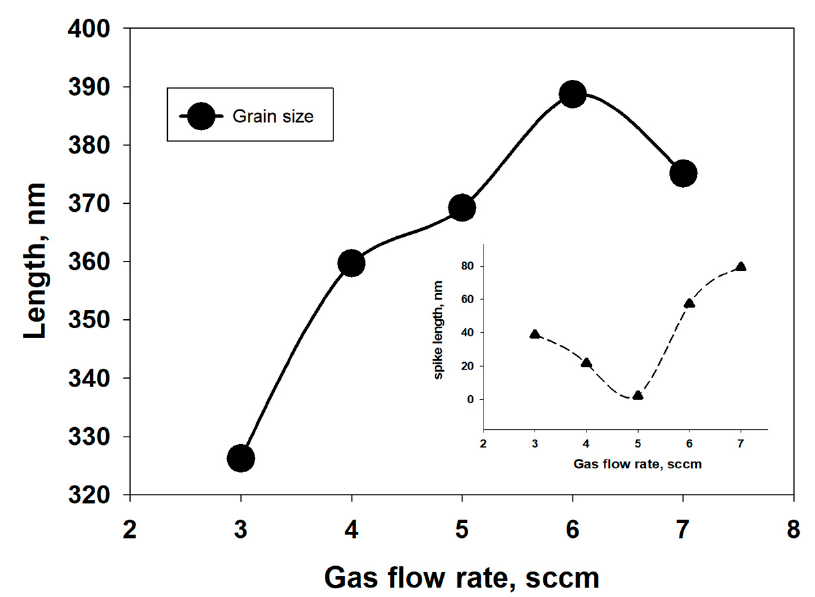
Figure 10. Spike and grain length vs. Ar gas flow rate .